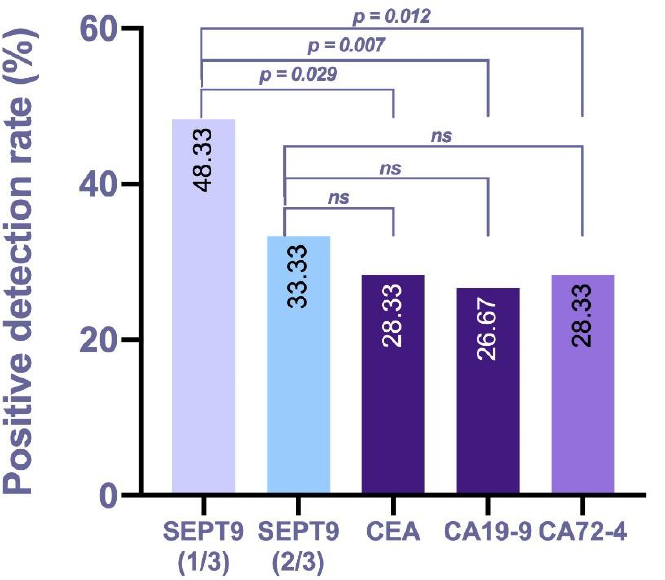
Figure 3. Positive rates of mSEPT9 and serum tumor markers in the GC group. The positive detection rate was compared by McNemer test. ns , not significant.